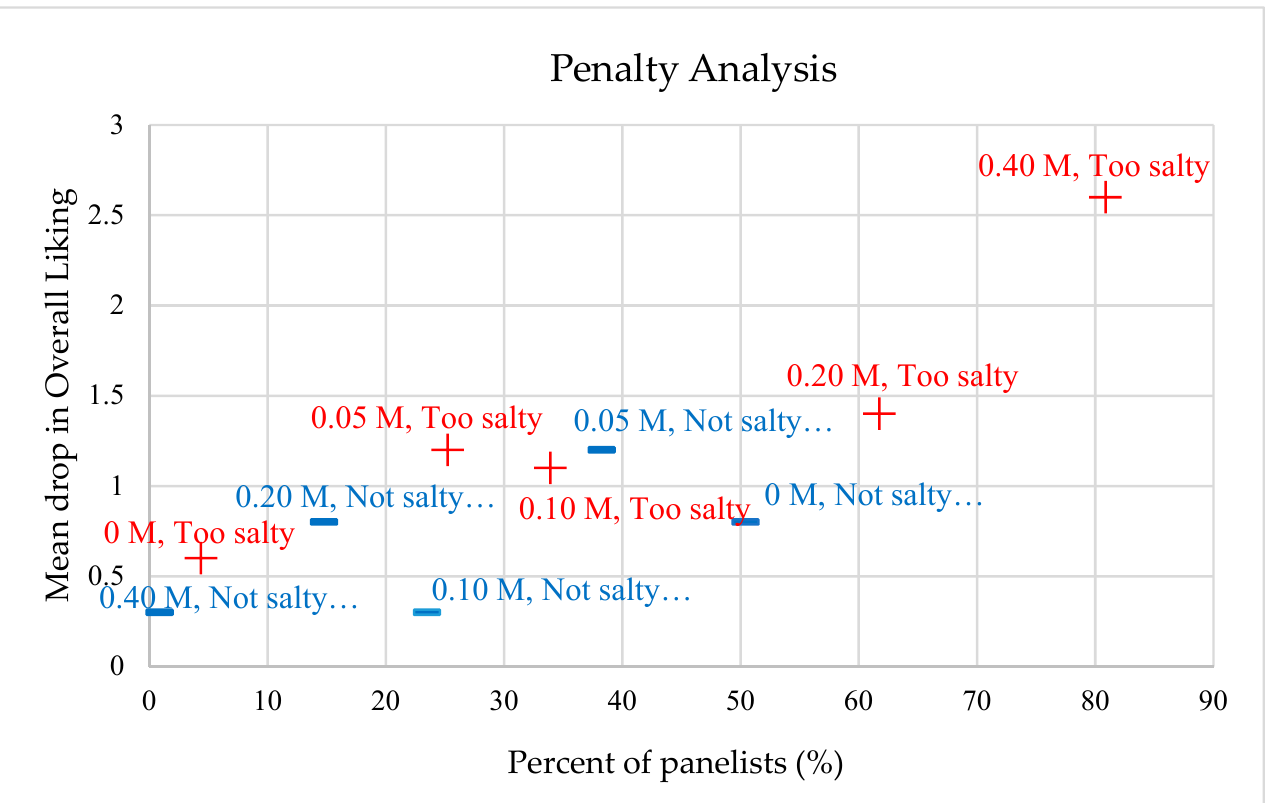
Figure 2. Penalty on overall liking of ice plant in response to sodium chloride (NaCl) treatment in hydroponic nutrient. The y -axis represents the mean difference between the sample overall liking rating, compared to the overall liking rating of panelists who found the sample “too salty” (Top 2 Box% (T2B%), 5 pt, red) or “not salty enough” (Bottom 2 Box% (B2B%), 5 pt, blue). The x -axis = percent panelists per category.